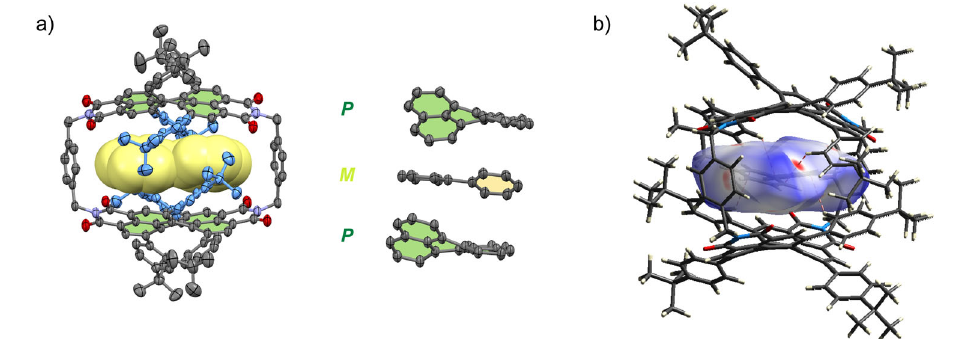
Fig. 7 | Single crystal X-ray analysis of a heterochiral complex. a Side view of molecular structure of M -1,1 ’ -biphenyl ⊂ 1- PP , obtained from single crystal X-ray analysis (surrounding guest molecules are omitted for clarity), corresponding perylene units with the encapsulated guest in order to visualize the heterochiral host-guest stacking. The perylene core of the PBI unit and the relevant bay